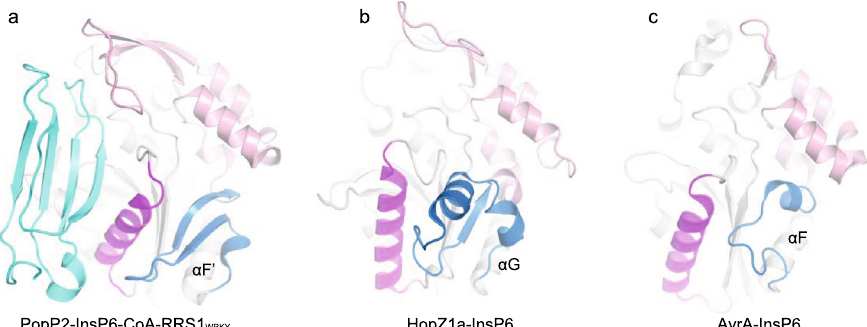
Fig. 6 YopJ family effectors may adopt a conserved mechanism to regulate substrate binding by InsP6. a Crystal structure of PopP2-InsP6-CoA- RRS1 WRKY complex (PDB code: 5W3X). The regulatory domain is colored in pink; the fold-switching region is colored in blue; the substrate recognition helix is colored in purple; the RRS1 WRKY domain is shown in cyan. Similar colors are used in b , c . b Crystal structure of HopZ1a-InsP6 complex (PDB code: 5KLP). c Crystal structure of Avra-InsP6-CoA complex (PDB code: